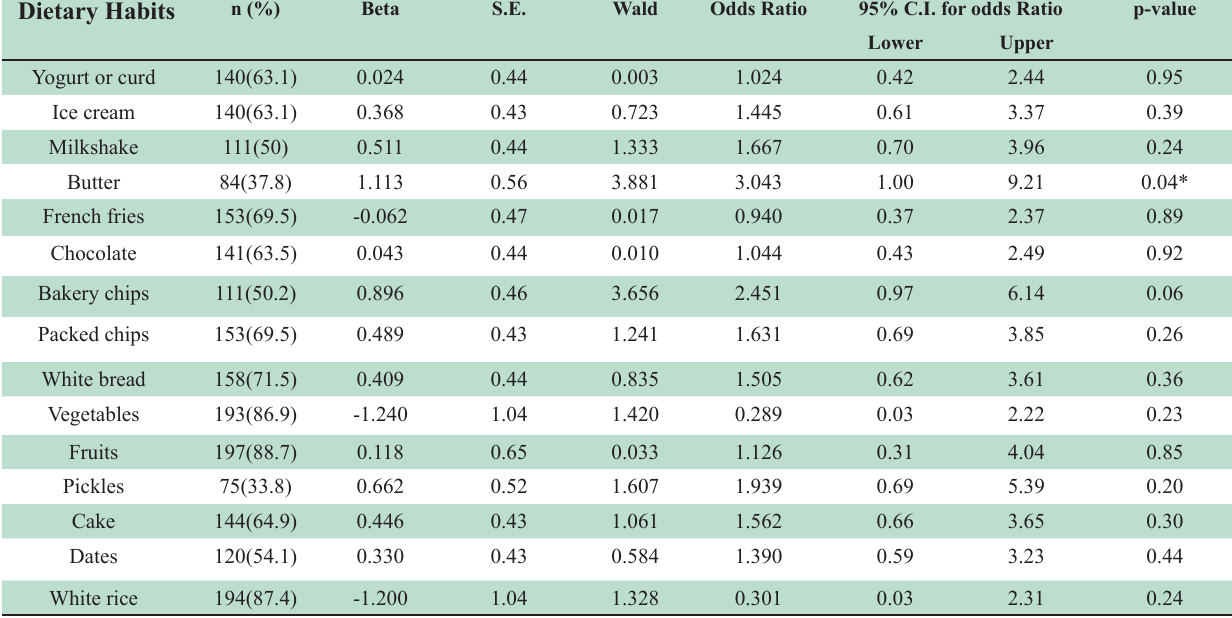
Table-V: Risk Estimation of Acne with Dietary Habits using Binary Logistic Dietary Habits